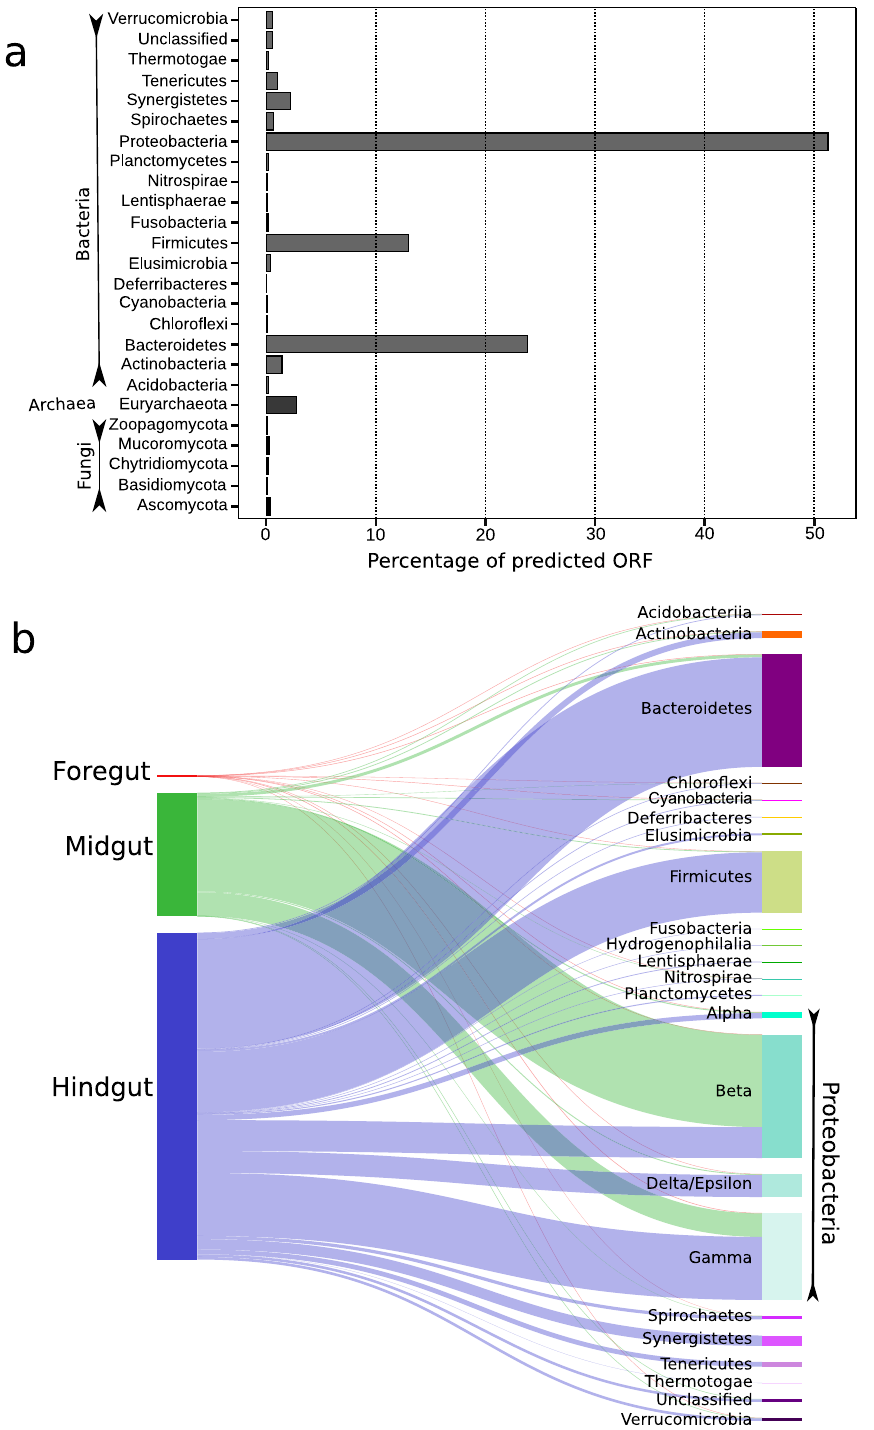
Figure 2. Taxonomic origin and distribution of functional microbiota in the millipede gut. ( a ) Bar plot showing the abundance of active microbiota in the millipede gut at the phylum level, assessed by the predicted ORF counts. ( b ) The abundance of functional bacterial phyla in the foregut, midgut, and hindgut of millipede species T. aoutii . The width of the connectors is proportional to the abundance of the taxa. Only the phylum Proteobacteria has been shown at the class